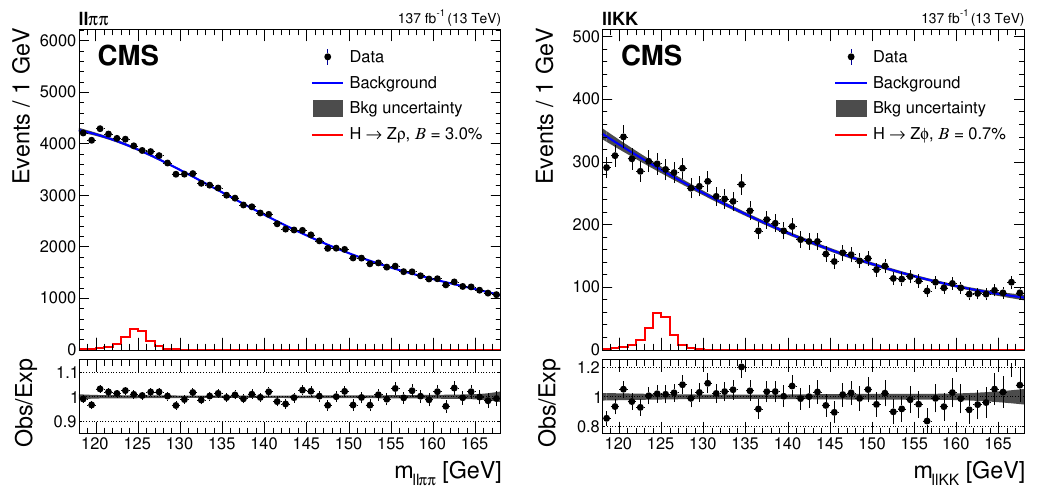
Figure 6 . Distributions of m (left) and m (right). For illustration the (cid:22)(cid:22) and ee channels, ‘‘ (cid:25)(cid:25) ‘‘ KK as well as all three data-taking periods, are combined. Also shown are the H → Z (cid:26) and H → Z (cid:30) signals, in the isotropic-decay scenario and assuming branching fractions of 3.0 and 0.7%, respectively. The ratio between the data and the background model is shown in the lower